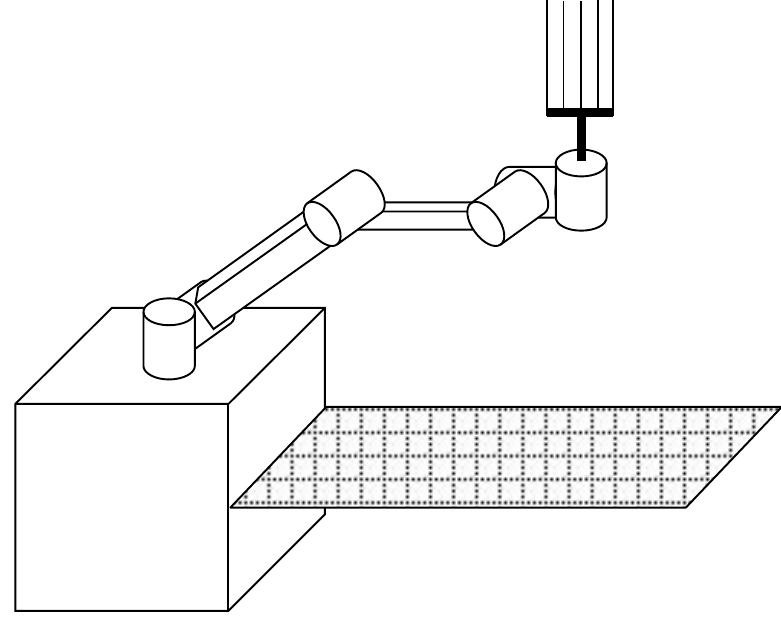
Figure 1. The space detumbling robot designed in this paper.